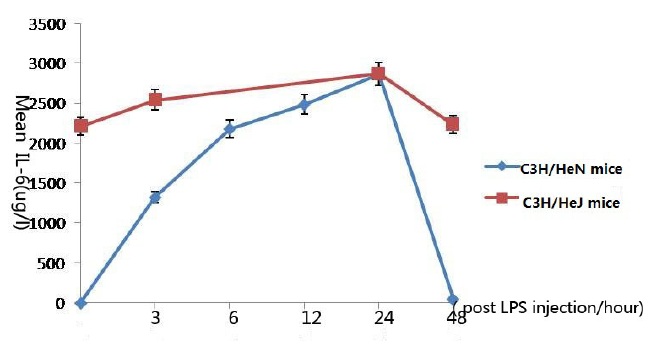
Figure 3. The expression levels of interleukin-6 in the aqueous humor at different time points (expressed as the mean μ g/L ± SD). The concentration of IL-6 in the aqueous humor of C3H/HeN mice reached a peak 24 h after injection, then gradually decreased. The concentration of IL-6 in the aqueous humor of C3H/HeJ mice reached a peak 24 h after injection, then gradually decreased.